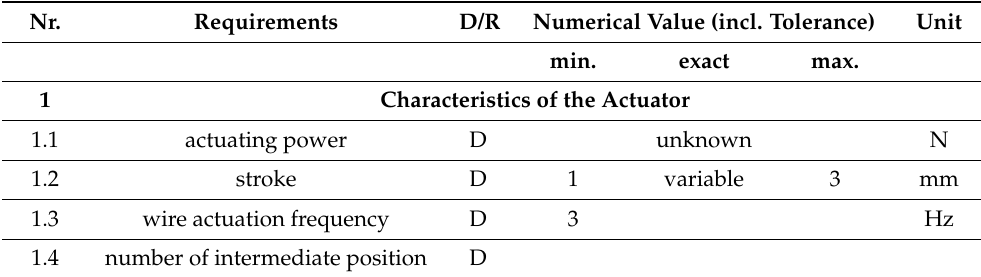
Table 1. Requirements of the shape memory alloy (SMA) actuator.